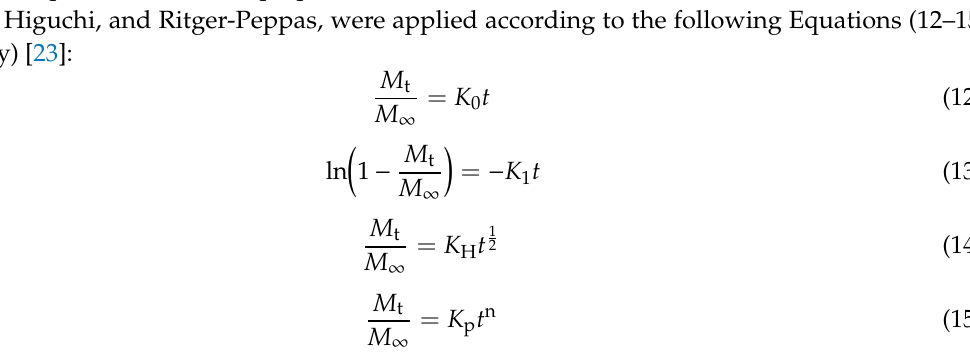
Figure 7. Cumulative release profiles of Sunitinib from MIP and NIP.